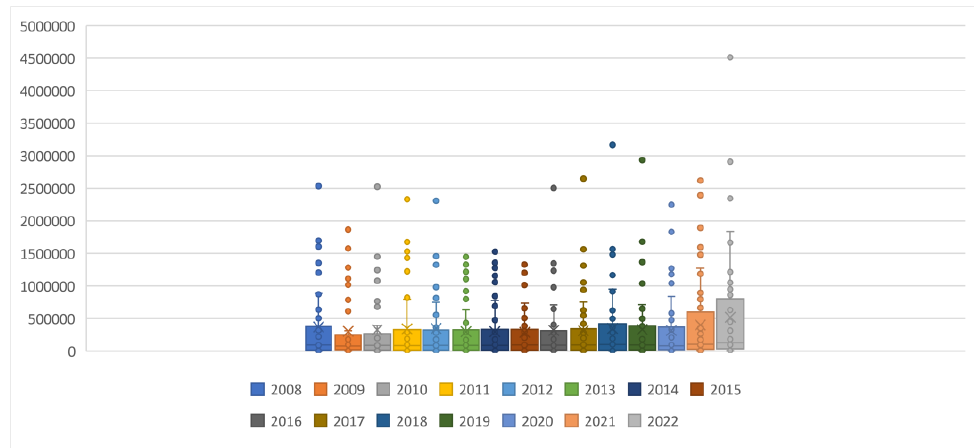
Figure 4. Inventory investment (absolute, ‘000 EUR) box plot from Finnish -stock-market-listed com- panies of manufacturing and trade during the period of 2008 – 2022 (the last year of 2022 only con- sisted of data from the first half of the